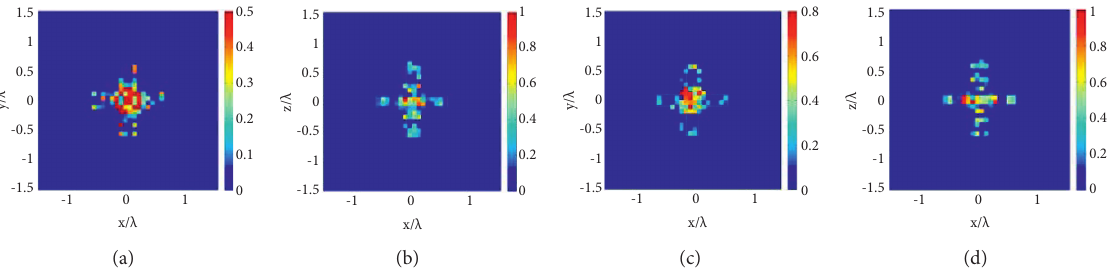
Figure 7: Cross-shaped dielectric target images obtained using multiple harmonics. (a) xOy plane and φ -oriented dipoles. (b) xOz plane and φ -oriented dipoles. (c) xOy plane and θ -oriented dipoles. (d) xOz plane and θ -oriented dipoles. The adopted signal-to-noise ratio was SNR � 10dB.